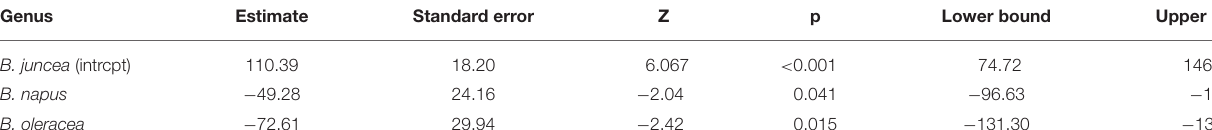
TABLE 3 | Result of meta-analysis using random-effects model and standard REML procedure to compare disease ratings across three species, Brassica napus , B. juncea and B. oleracea , upon artificial inoculation of Neopseudocercosporella capsellae .